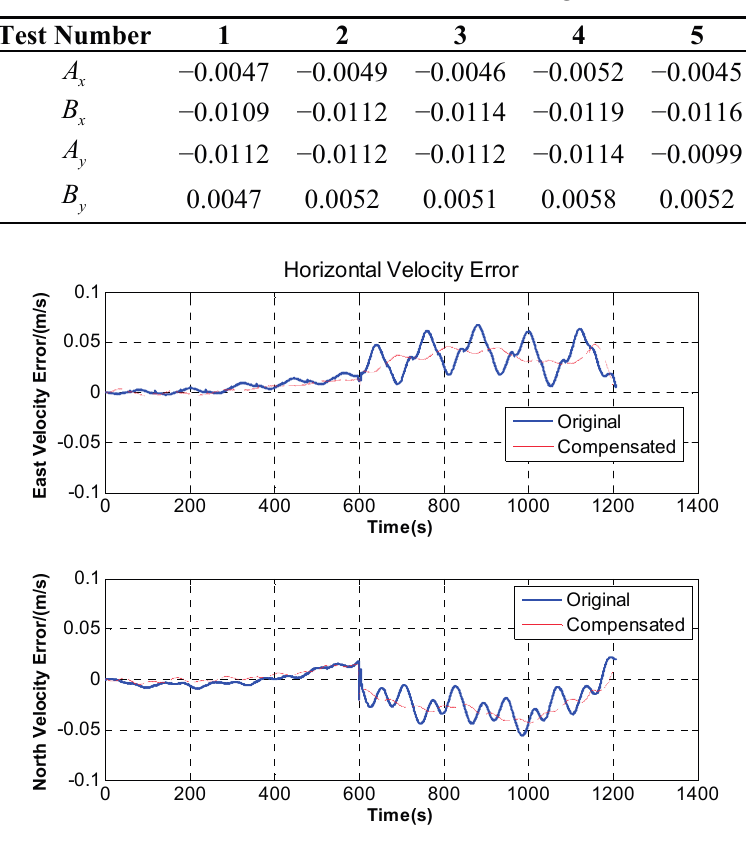
Figure 12. Comparison of original and compensated velocity fluctuation error. Figure 12 indicates that after velocity compensation, the fluctuation on horizontal velocity almost